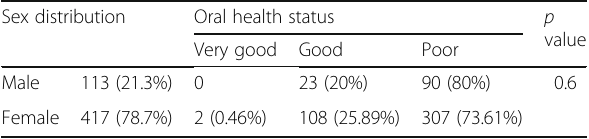
Table 2 Oral health status according to sex